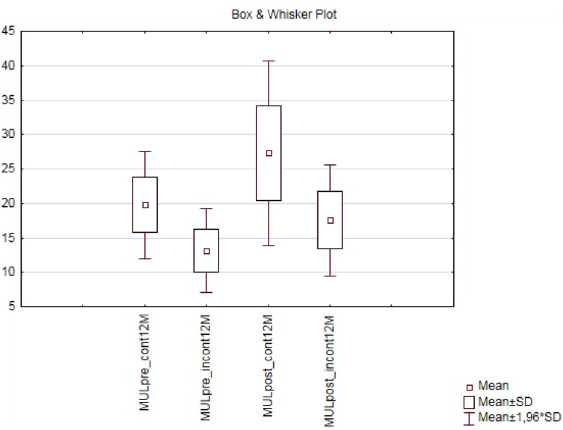
Figure 5. Comparison of membranous urethra length measured preoperatively (MULpre) and postoperatively (MULpost) in a subgroups of patients continent (cont 12 M) and incontinent (incont12M) after 12 months follow up; (CI 95%, p = 0.0005).